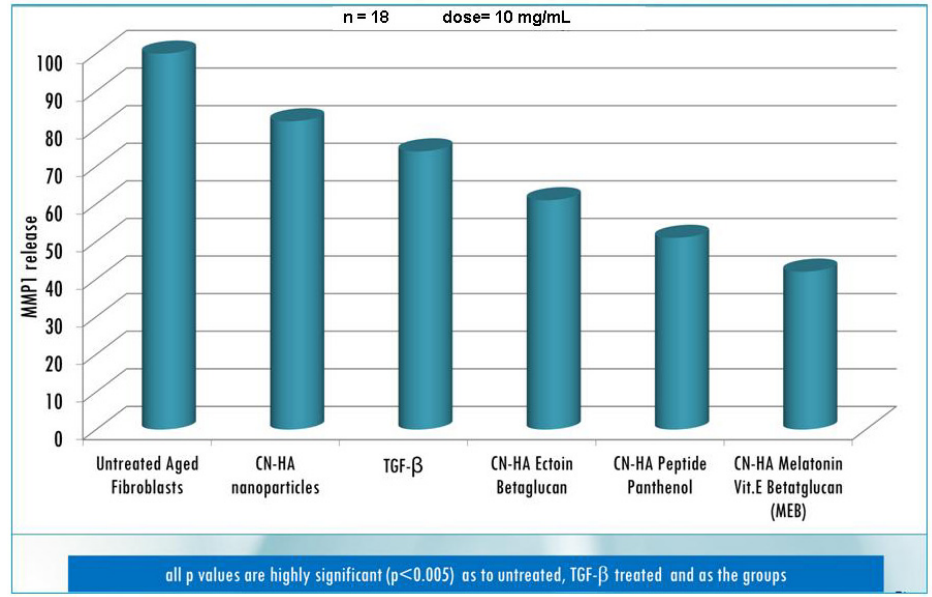
Figure 15. MMPl release in aged fibroblasts treated by chitin nanofibril-hyaluronan (CN-HA) entrapping active ingredients. All p values highly significant ( p < 0.005) as untreated, TGF- β (Tumour Growth Factor- β ) treated and as groups.